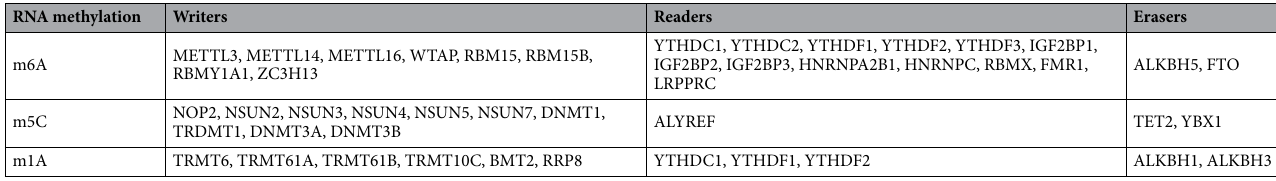
Table 1. Methylation (m6A/m5C/m1A)-related genes.